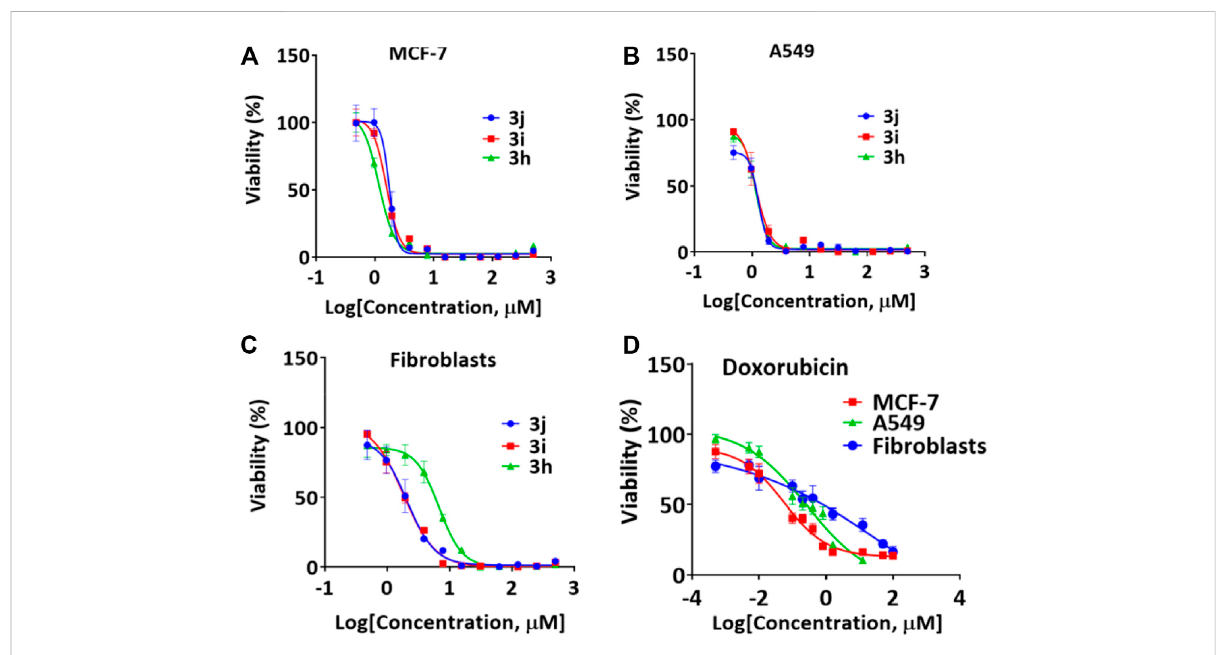
FIGURE 3 Representative cell viability results used to calculate the IC 50 values for compounds (A) 3h (B) 3i , (C) 3j , and (D)